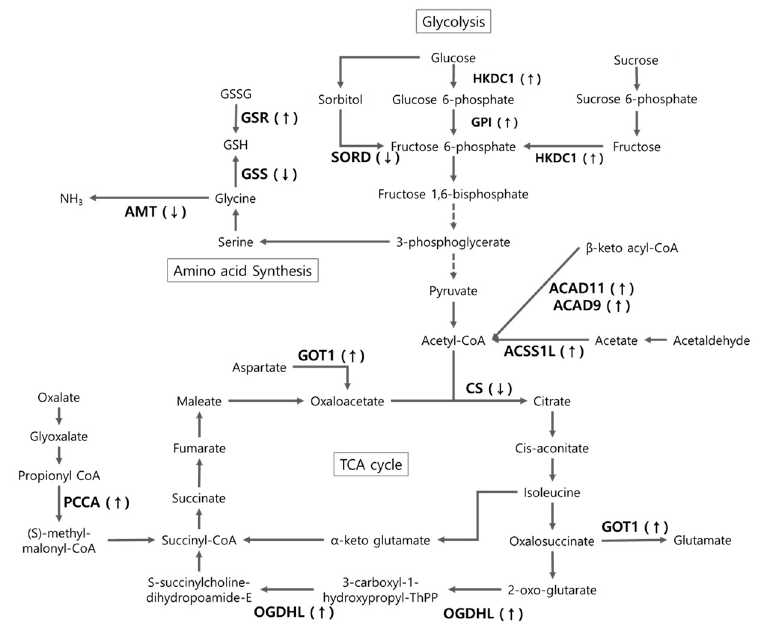
Figure 5. Metabolic schematic of di ff erentially expressed proteins. ( ↑ ) or ( ↓ ) sign showed significantly up or downregulated in CH group compared to CC and / or